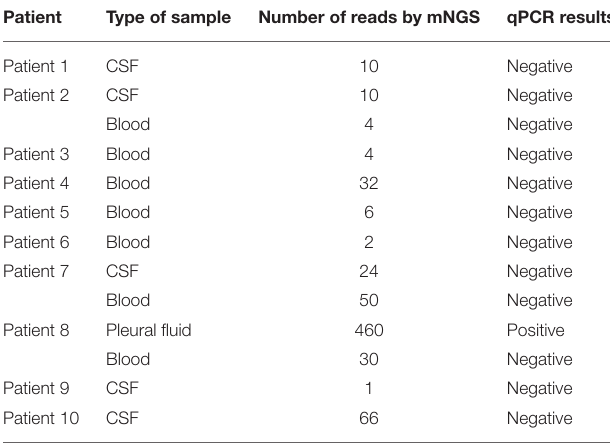
TABLE 3 | The types of samples and the results of mNGS and qPCR.